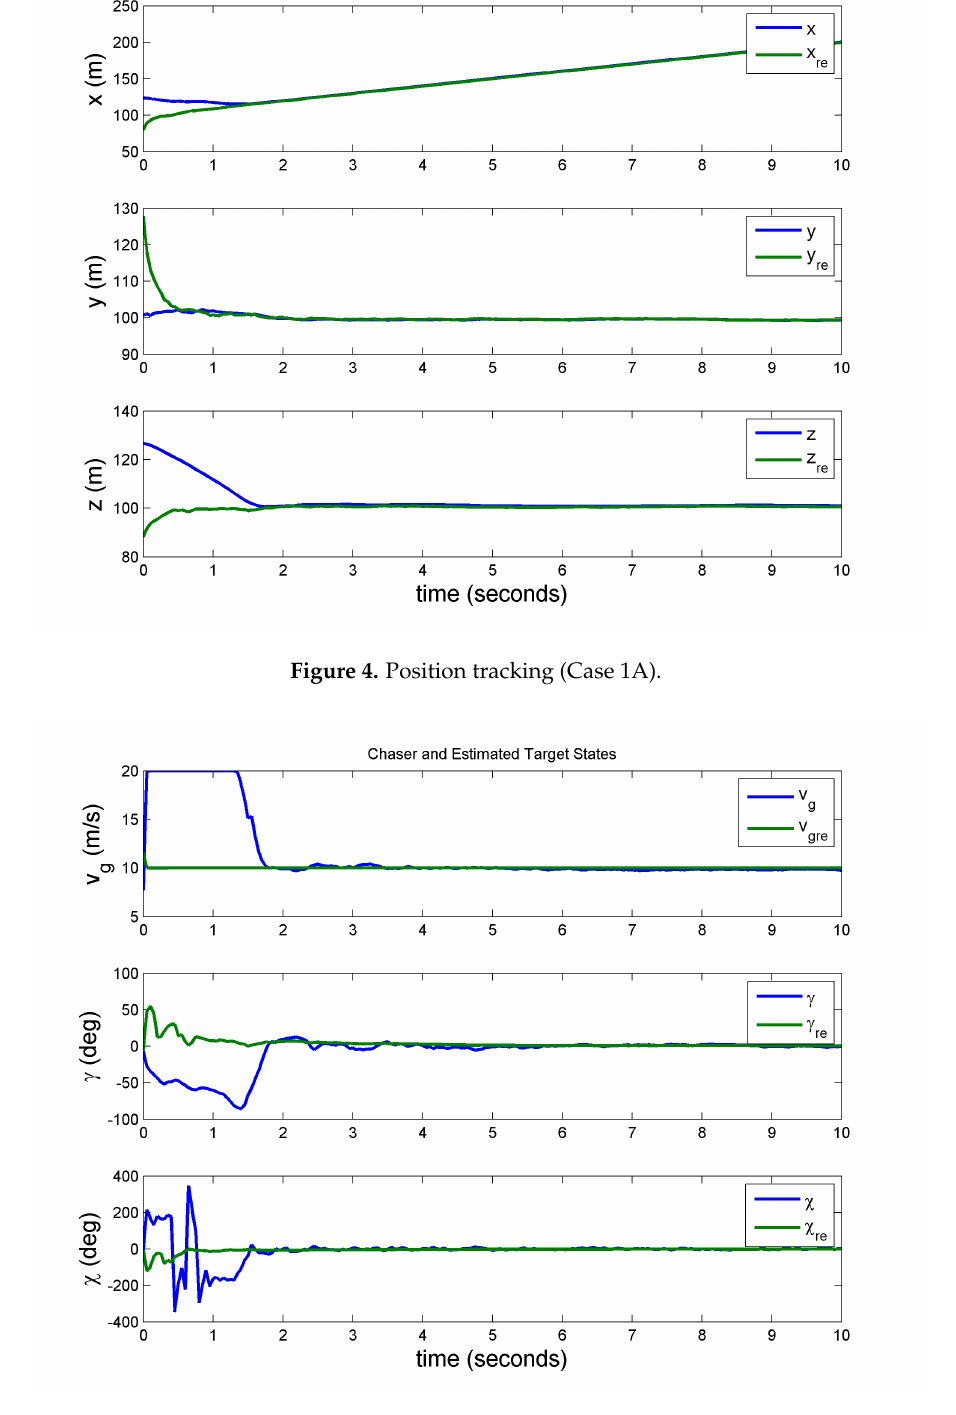
Figure 5. Speed, flight path angle and heading angle tracking (Case